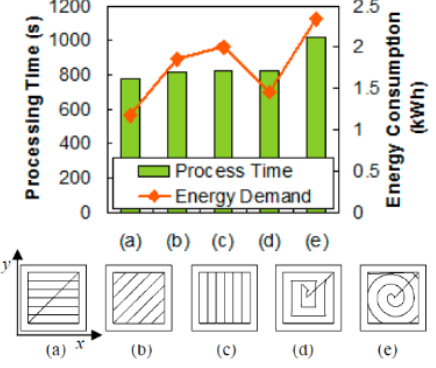
Figure 4. (a – e) Processing time and energy consumption of various tool paths. (Reproduced with permission from [58], Elsevier, 2011)